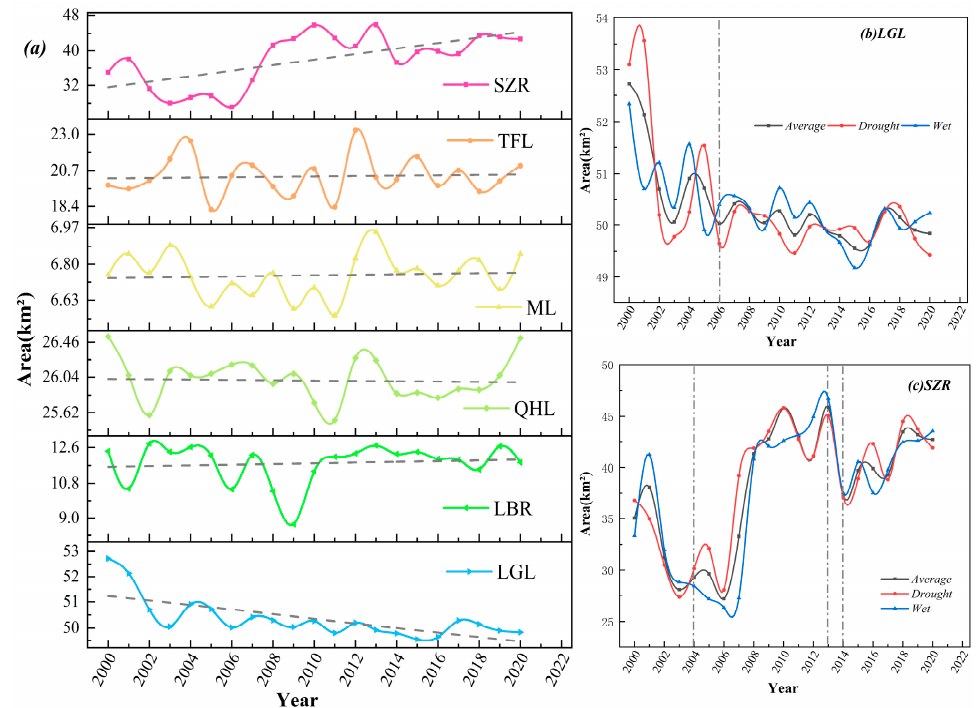
Figure 5. Lake area. ( a ) Trends in the average annual area of the six lakes; ( b ) Annual average change in area of the Lugu Lake from drought to wet season; ( c ) Annual average change in area of the Shengzhong Reservoir from drought to wet season.